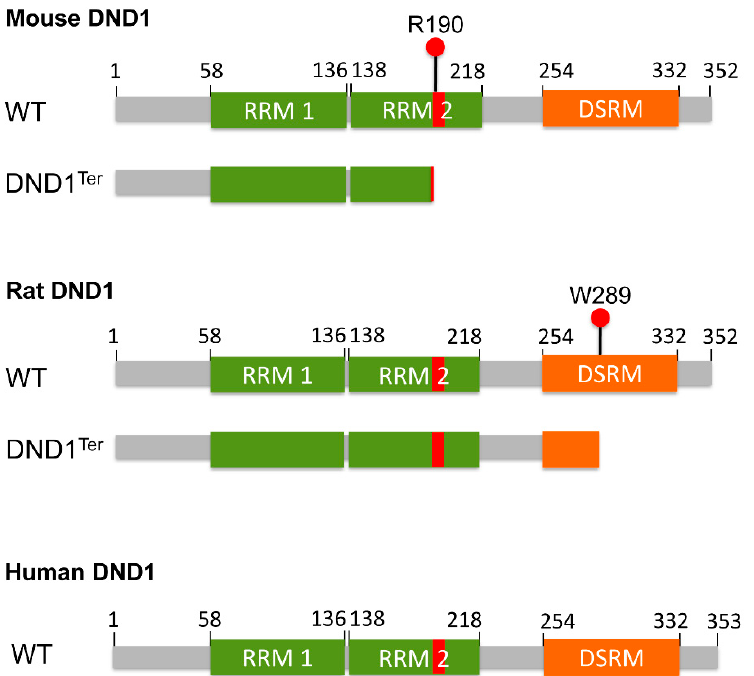
Figure 1. Schematic representation of the structure of mouse, rat, and human DND1 proteins. The RNA recognition motif 1 (RRM1), RNA recognition motif 2 (RRM2) and double stranded RNA- binding motif (DSRM) are shown. Ter mutation transforms arginine at amino acid (aa) 190 in mouse and tryptophan at aa 289 in rat DND1 into a premature stop codon. The red bar in RRM2 represents the HRAAAMA motif spanning from aa 189 to 195 in all three species. The predicated mouse and rat DND1 Ter protein are also shown underneath the wild-type (WT) protein, respectively. Please note that whether DND1 Ter causes truncation or loss of DND1 expression is still controversial. The NCBI Reference Sequence numbers for mouse, rat and human DND1 proteins are NP_775559.2, NP_001102849.1 and NP_919225.1, respectively, accessed on 20 July 2021.